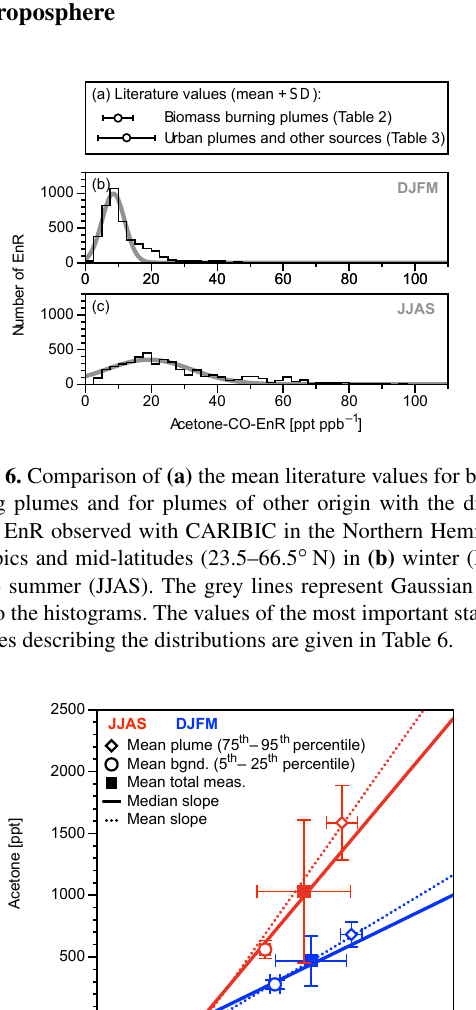
Figure 7. Regression lines for summer (red) and winter (blue), us- ing mean slope (solid line) and median slope (dotted line) given in Table 6. The filled squares represent the mean VMRs of the total measurements, whereas the open circles (diamonds) are the mean of all values lying in the 5th to 25th (75th and 95th) percentile, re-